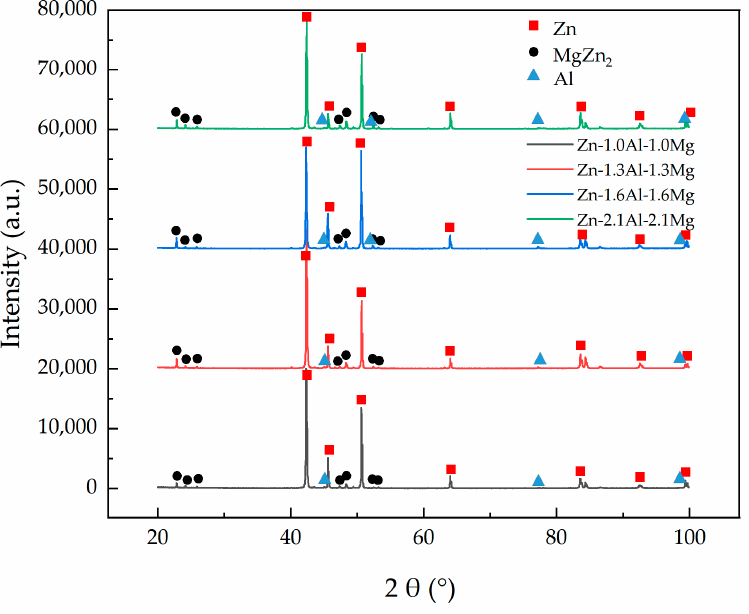
Figure 3. XRD Analysis of experimental coatings.